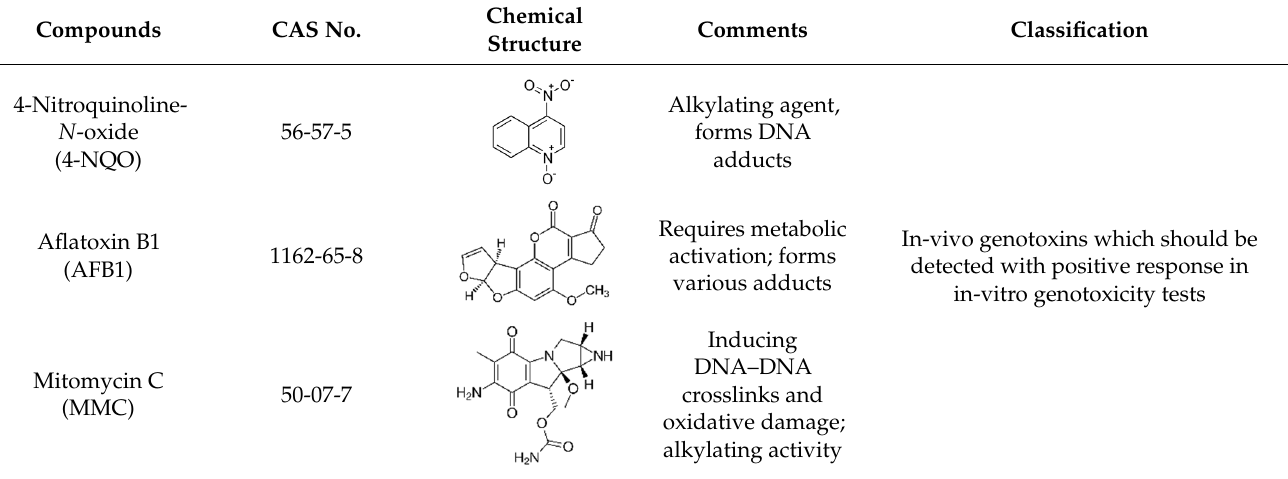
Table 1. Selected reference compounds with different mechanisms of